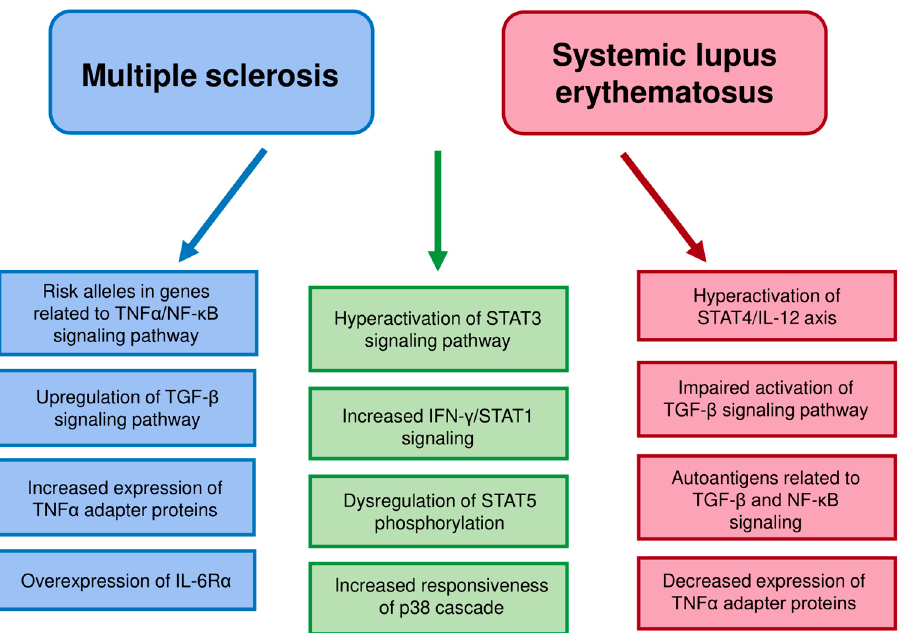
Figure 1. The main similarities and differences in T cells pathway dysregulation between MS and SLE. Similarities are marked in green. The MS dysregulation features distinct from SLE are marked in blue and SLE dysregulation features distinct from MS in red. Table 1. Comparison of quantitative alterations in proteins of JAK-STAT, TGF- β and TNF α signaling pathways in multiple sclerosis and systemic lupus erythematosus. Arrows indicate a decrease/an increase and “?” – no data.. A “p” denotes a phosphorylated residue.